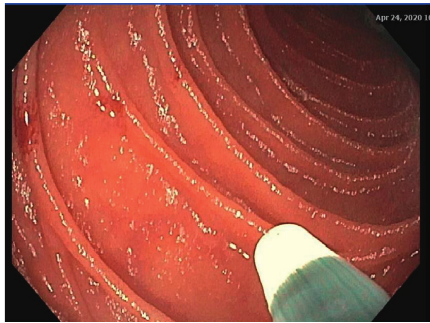
Figure 3: Two arteriovenous malformations in the